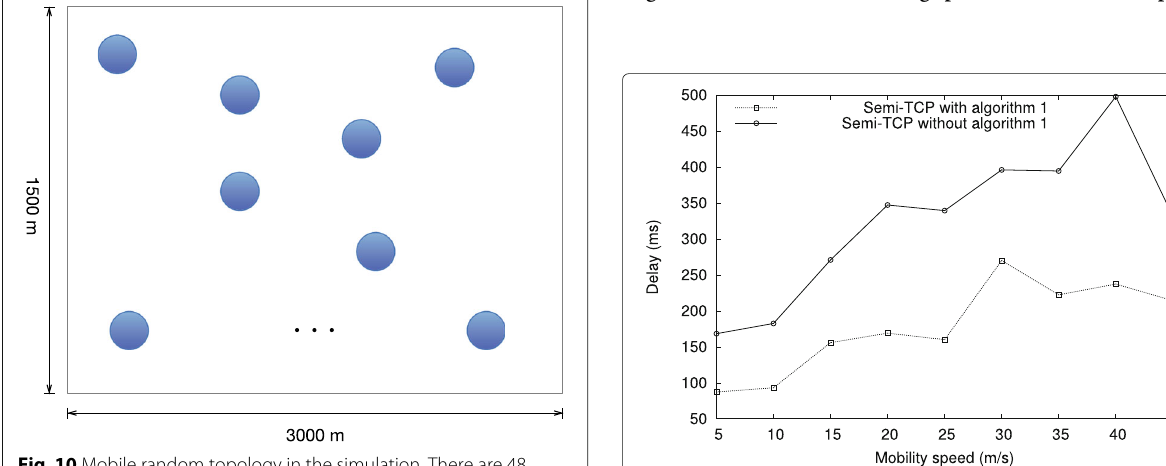
Fig. 12 End-to-end delay in the random